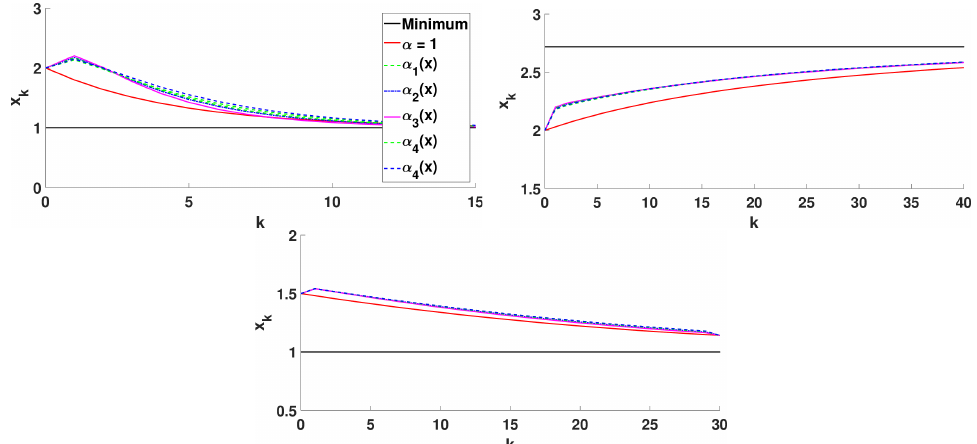
Figure 4. Algorithm 1 for different variable orders of